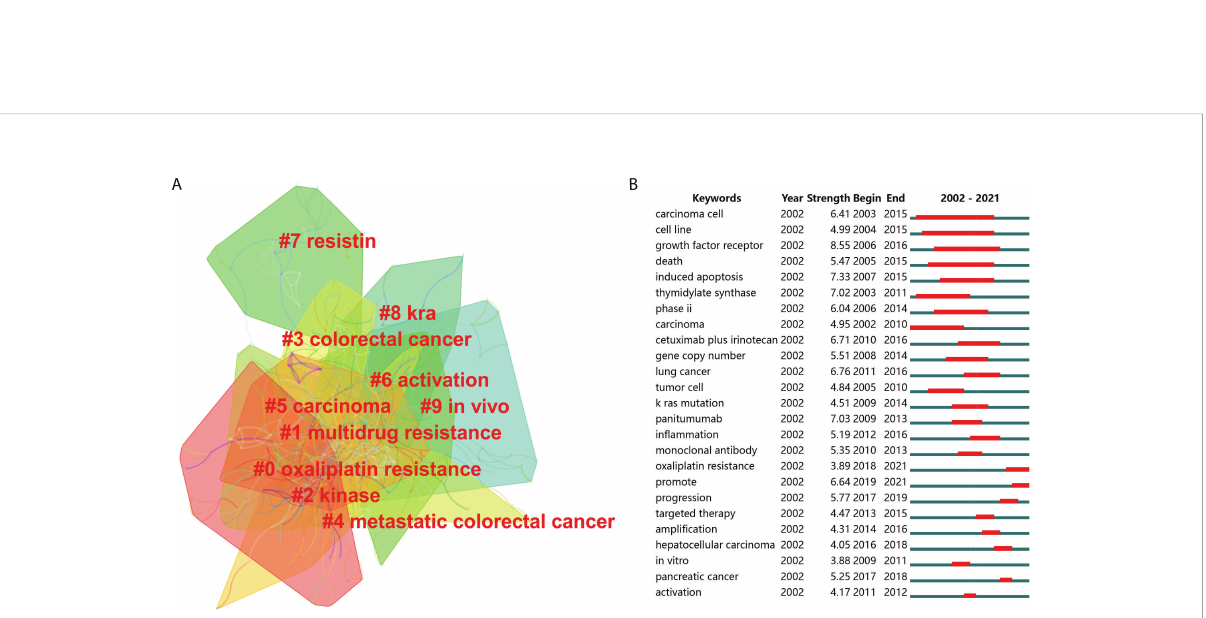
FIGURE 8 (A) The cluster of keywords related to colorectal cancer drug resistance. The different colors represented different clusters. (B) Top 25 keywords with the strongest citation bursts. The blue line represents the time axis, and the red portion on the blue time axis represents the interval at which the burst was found, including the start year, end year, and burst